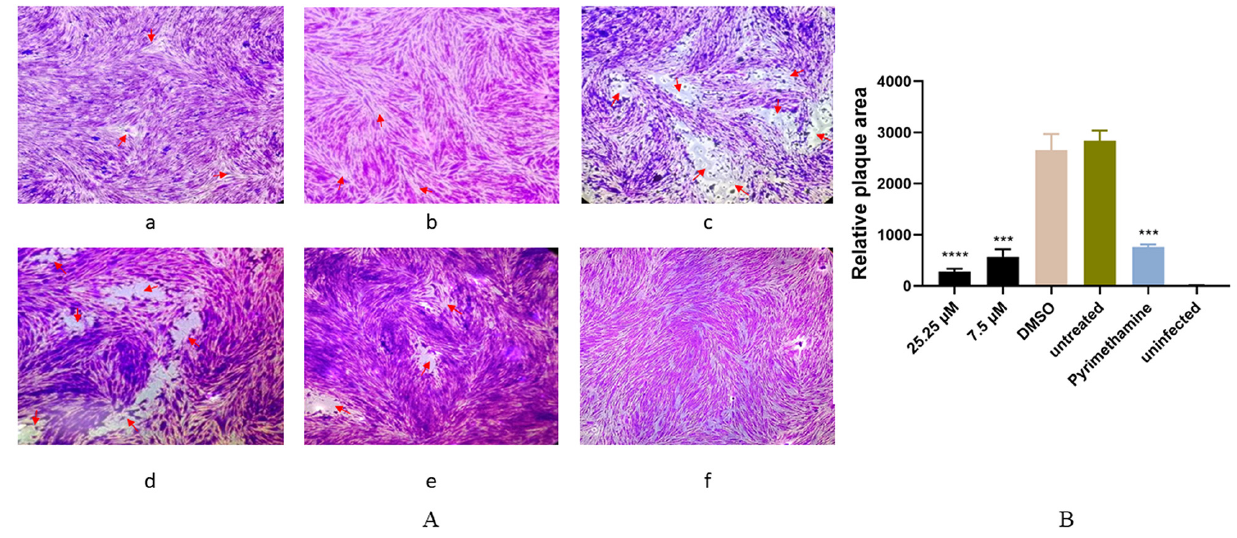
Figure 2. Plaque test for preliminary detection of the anti- T. gondii activity of artemether. T. gondii plaques were observed and counted when cells were treated with different concentrations of artemether for 7 days. ( A ): ( a , b ) HFF cells infected by T. gondii and treated with artemether of 25.25 µ M or 7.5 µ M. ( c , d ) HFF cells infected by T. gondii and treated with DMSO or untreated. ( e ) HFF cells infected and treated with pyrimethamine as positive control. ( f ) HFF cells were not infected and untreated. ( B ): The relative areas of plaque in each group were calculated. All the above experiments were repeated three times and 3 technical replicates were included in each experiment. Red arrows ( T. gondii plaques) *** p < 0.001, **** p <